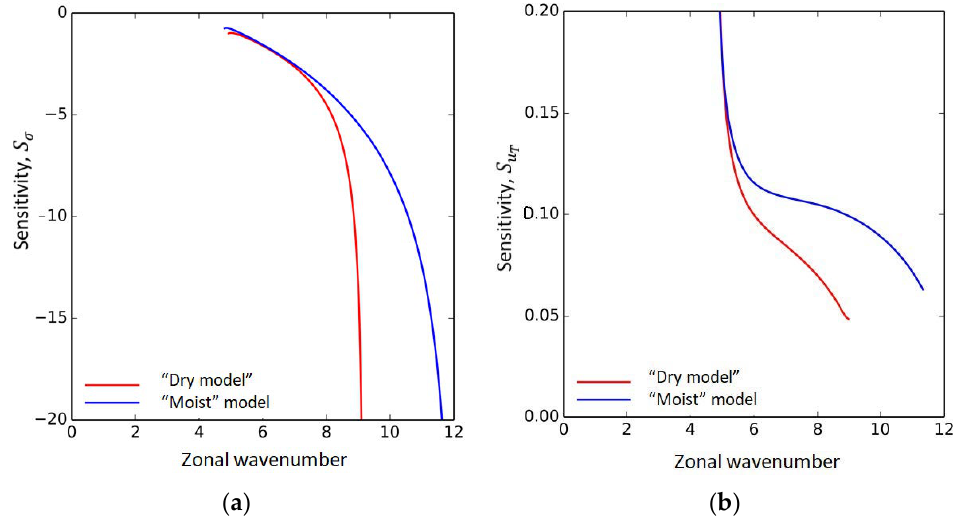
Figure 4. Sensitivity functions ( a ) S σ and ( b ) S u for “dry” and “moist” models. T By varying both σ 0 and u T , one can assess the impact of climate change on χ k